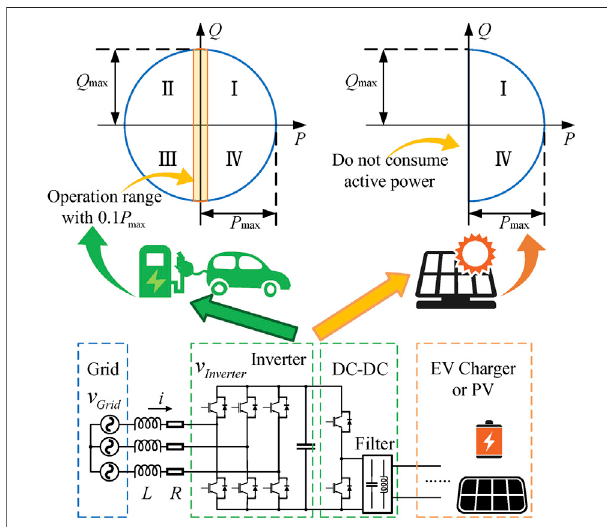
FIGURE 1 | Topology and operation range of smart inverters.